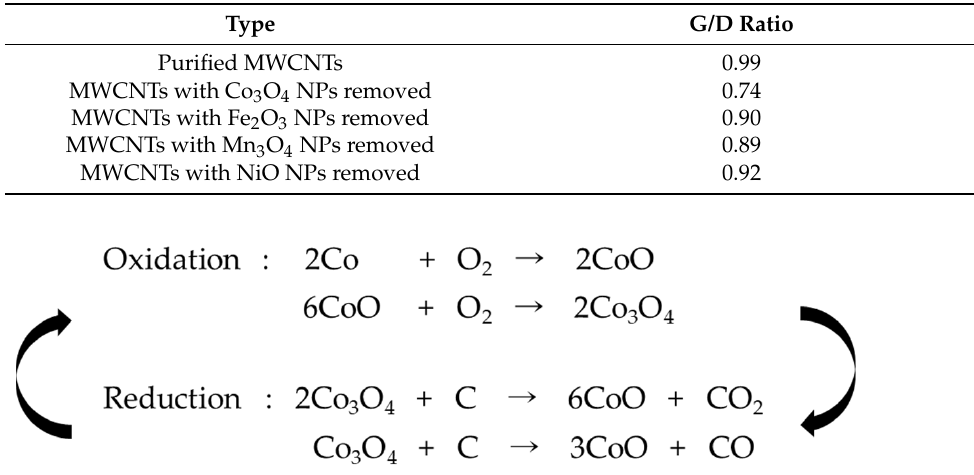
Figure 9. Reaction mechanism of MWCNT@Co 3 O 4 .